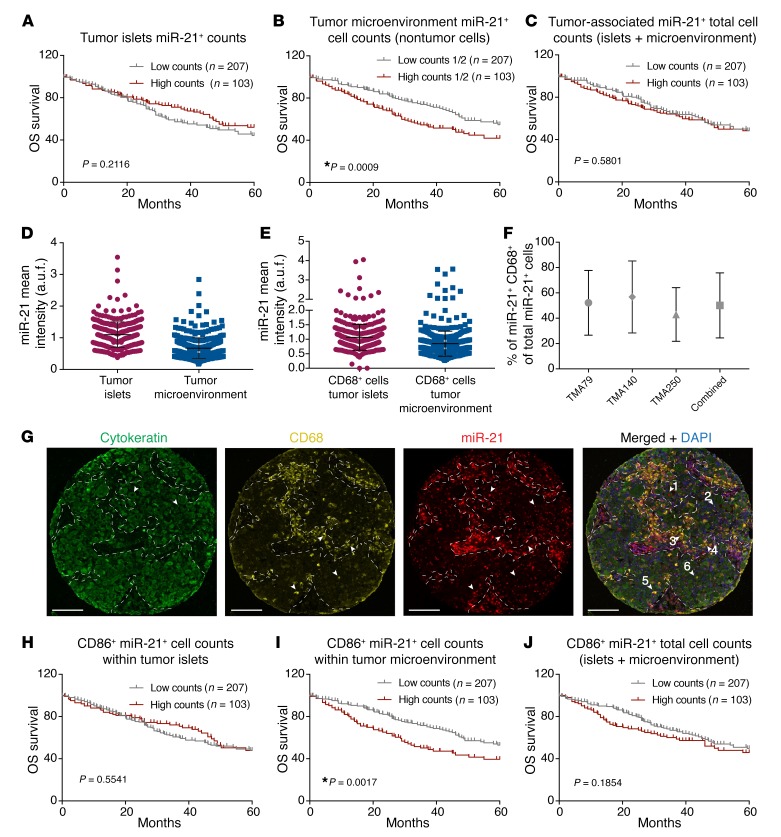
High expression of miR-21 in CD68+ cells of the TME of NSCLC regulates disease outcome.(A–C) Kaplan-Meier 5-year OS survival curves of patients with NSCLC in a combined analysis of 3 Yale cohorts; patients were stratified by the median of normalized miR-21–positive cell counts in (A) TIs, (B) TME, and (C) total cells. (D) Quantitative immunofluorescence of miR-21 in TI and TME cell compartments. (E) Quantitative immunofluorescence intensity of miR-21 in CD68+ cells in TI and TME cell compartments. (F) Analysis of the percentage of miR-21+ Cd68+ of total miR-21+ cells in the 3 Yale cohorts independently and combined. (G) Representative cytokeratin immunostaining, miR-21 FISH, and CD68 immunostaining of a random spot of YTMA250. Dashed lines delimit TI (cytokeratin-enriched areas) from TME. Arrowheads no. 1 and no. 2 indicate cytoketatin+ cells in TI with high or low miR-21 intensity, respectively. Arrows no. 3 and no. 4 indicate CD68+ cells in TME with high or low miR-21 intensity, respectively. Arrows no. 5 and no. 6 indicate CD68+ cells in TI with high or low miR-21 intensity, respectively. Scale bar: 100 μm. (H–J) Kaplan-Meier OS survival curves of patients with NSCLC in a combined analysis of 3 Yale cohorts; patients were stratified by the top tertile of normalized double-positive cell counts (miR-21+ CD68+) in (H) TI, (I) TME, and (J) total cells. (A–C and H–J) Kaplan–Meier survival curves compared by log-rank test. *P < 0.05.